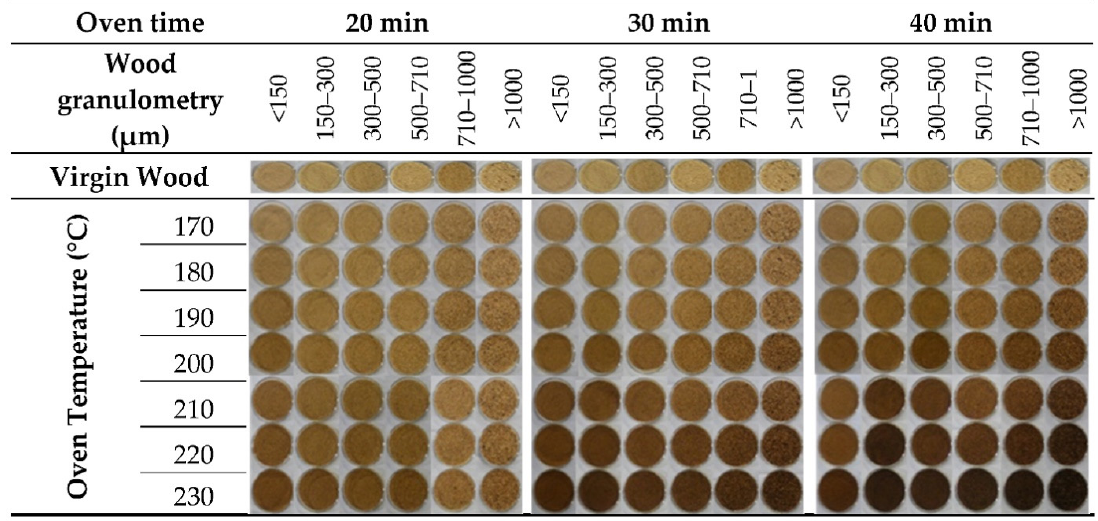
Figure 5. Effect of heat treatment conditions on the color of wood with different granulometries.